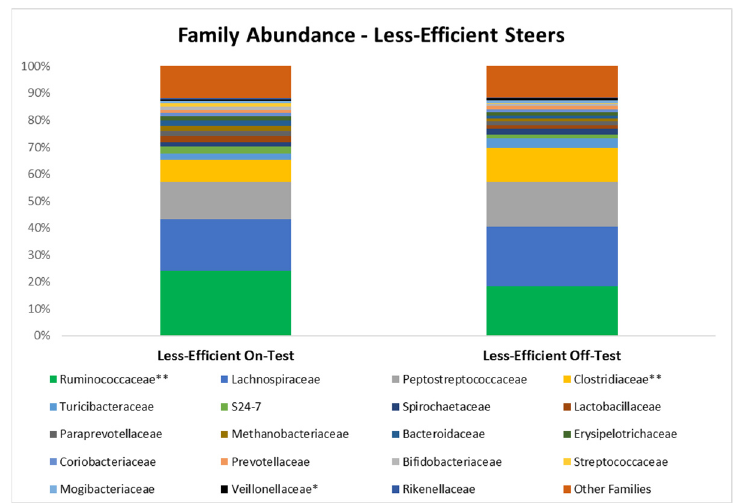
Figure 2. Relative abundance of the main families detected in the feces of the less efficient (High RFI) steers at the beginning (on-test; d 0) and end (off-test; d 82) of the feedlot phase. * Indicates a trend (0.05 < p ≤ 0.10). ** Indicates a difference ( p ≤ 0.05) in abundance of the family.